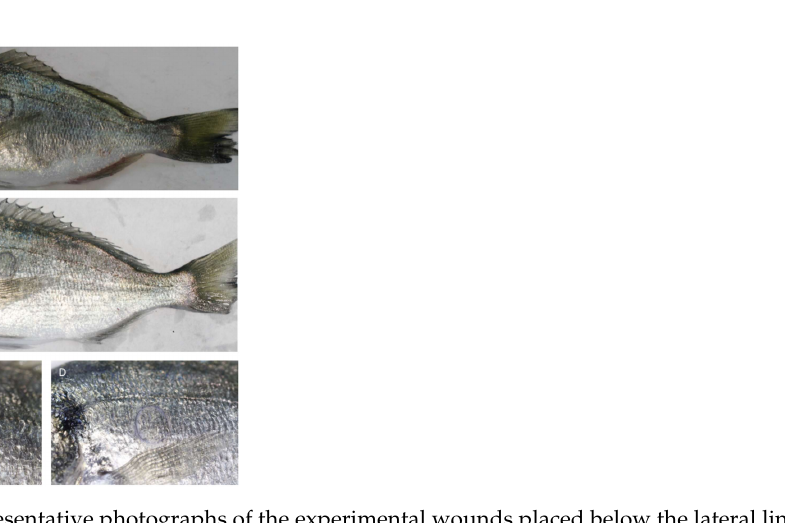
Figure 4. Representative photographs of the experimental wounds placed below the lateral line on the left flank of gilthead seabream specimens. The photographs were taken at 3 ( A , C ) and 7 ( B , D ) days post